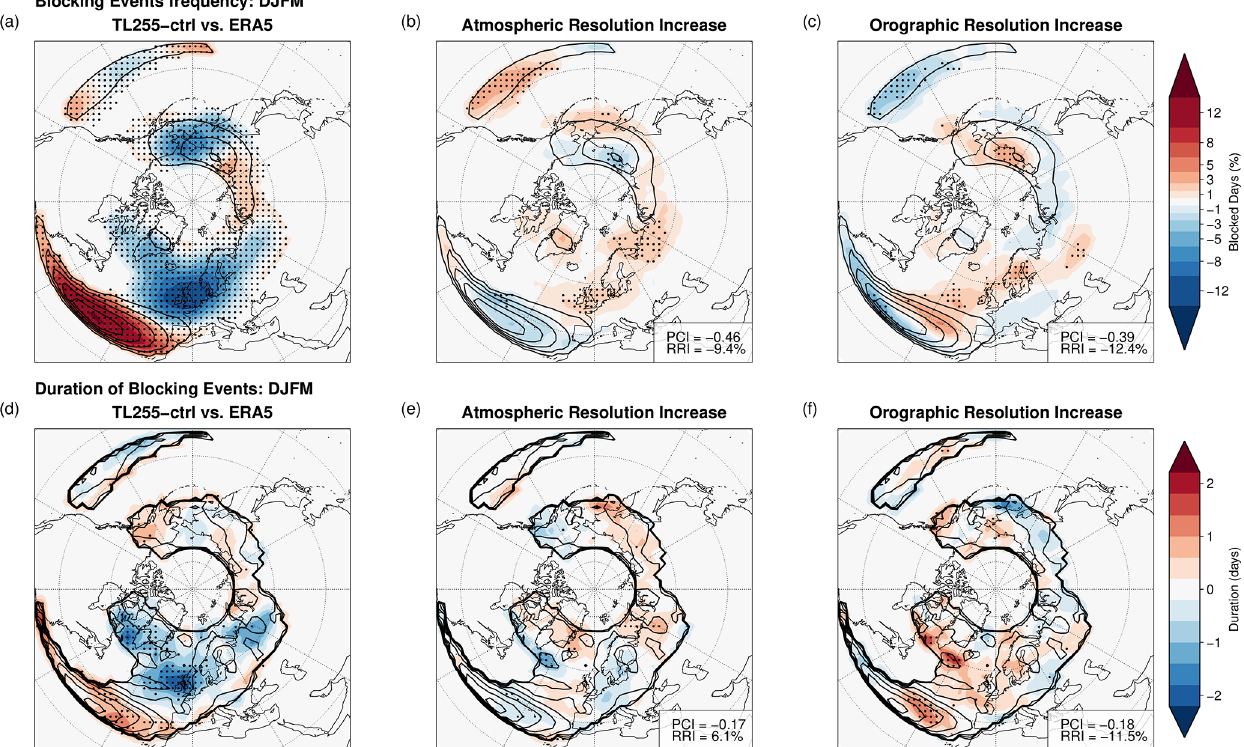
Figure 4. DJFM blocking event (BE) frequency (a–c) and BE duration (d–f) for (a, d) EC-Earth3 TL255-ctrl bias with respect to ERA5, (b, e) changes induced by the atmospheric resolution increase and (c, f) changes induced by the orographic resolution increase. Shading shows differences and contours the TL255-ctrl field. For BE frequency, please note the irregular colour-bar spacing. For BE frequency, contours mark every 5%. For blocking duration, contours mark every 0.5d. Stippling indicates significance with a Welch t test at the 5% level. In (b) , (c) , (e) and (f) the PCI and RRI (see text for details) are reported at the bottom left of each panel: large negative values imply reduced